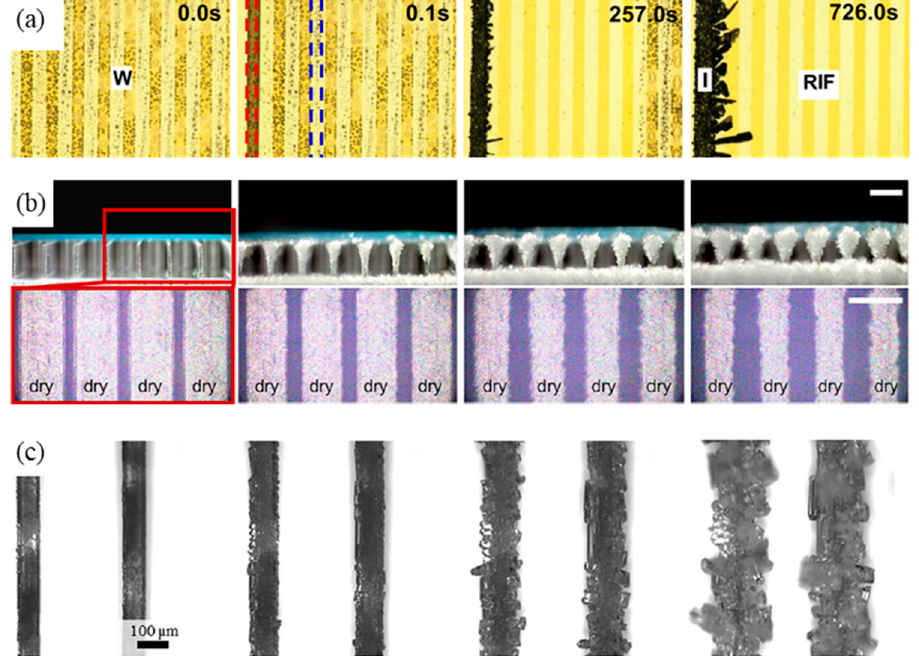
Figure 7. Condensation frosting on ( a ) a polyelectrolyte brush surface, Reprinted with permission from [70], Copyright 2020 American Chemical Society. ( b ) an ice-patterned aluminum surface, Reprinted with permission from [71], Copyright 2018 American Chemical Society. and ( c ) an ice walls patterned surface ,Reprint from [72], Copyright 2023 with permission from Elsevier.